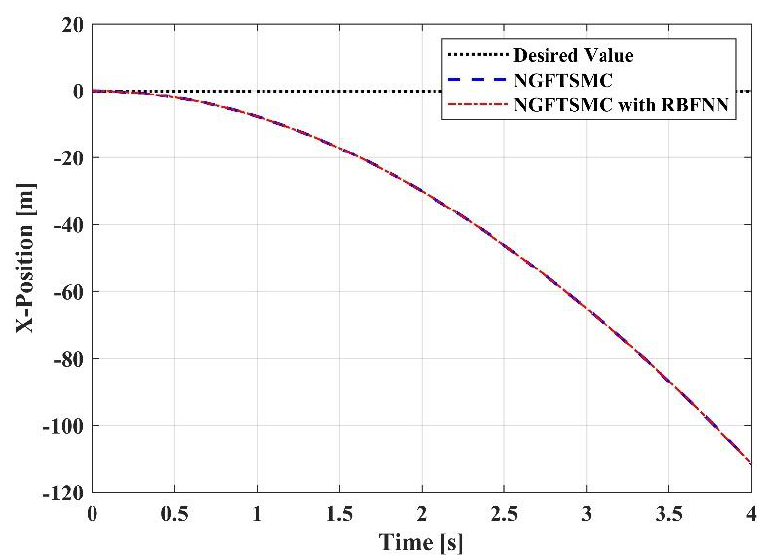
Figure 6. The trajectory tracking results in X-Position.